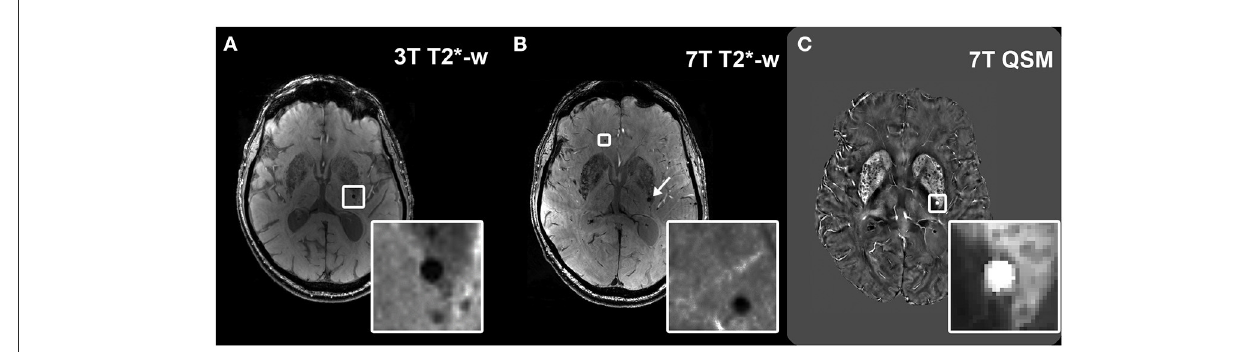
FIGURE1 Visualization of microbleeds on different sequences. Example of a microbleed (MB) visualized as a hypointense round structure in the deep brain region at 3T T2*-w imaging (A) ; visualization of the same brain region in the same subject at 7T T2*-w imaging, which shows the same MB (arrow) and an additional MB that had remained undetected at 3T (inset) (B) . Hyperintense appearance of the deep MB (inset) in the same subject on 7T QSM (C)